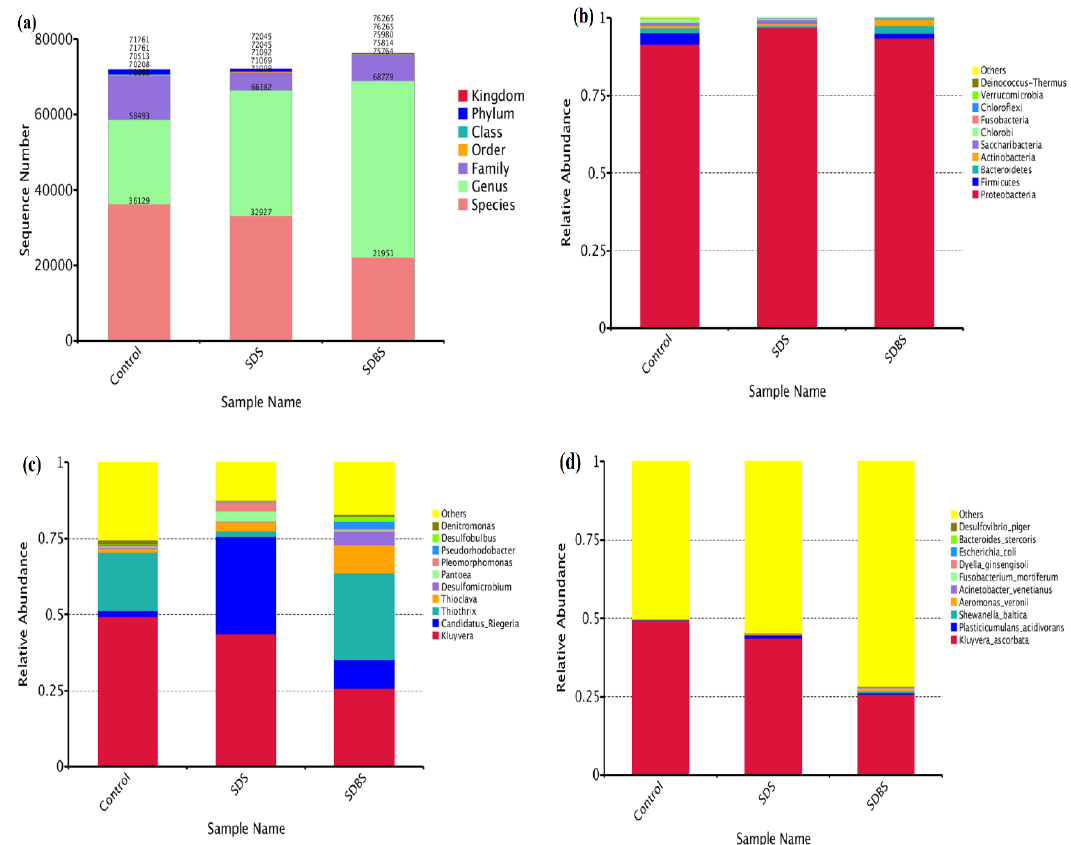
Figure 3. Operational taxonomic unit (OTU) numbers of the 3 samples: ( a ) at the seven taxonomic levels; ( b ) at the phylum level; ( c ) at the genus level; and ( d ) at the species level.